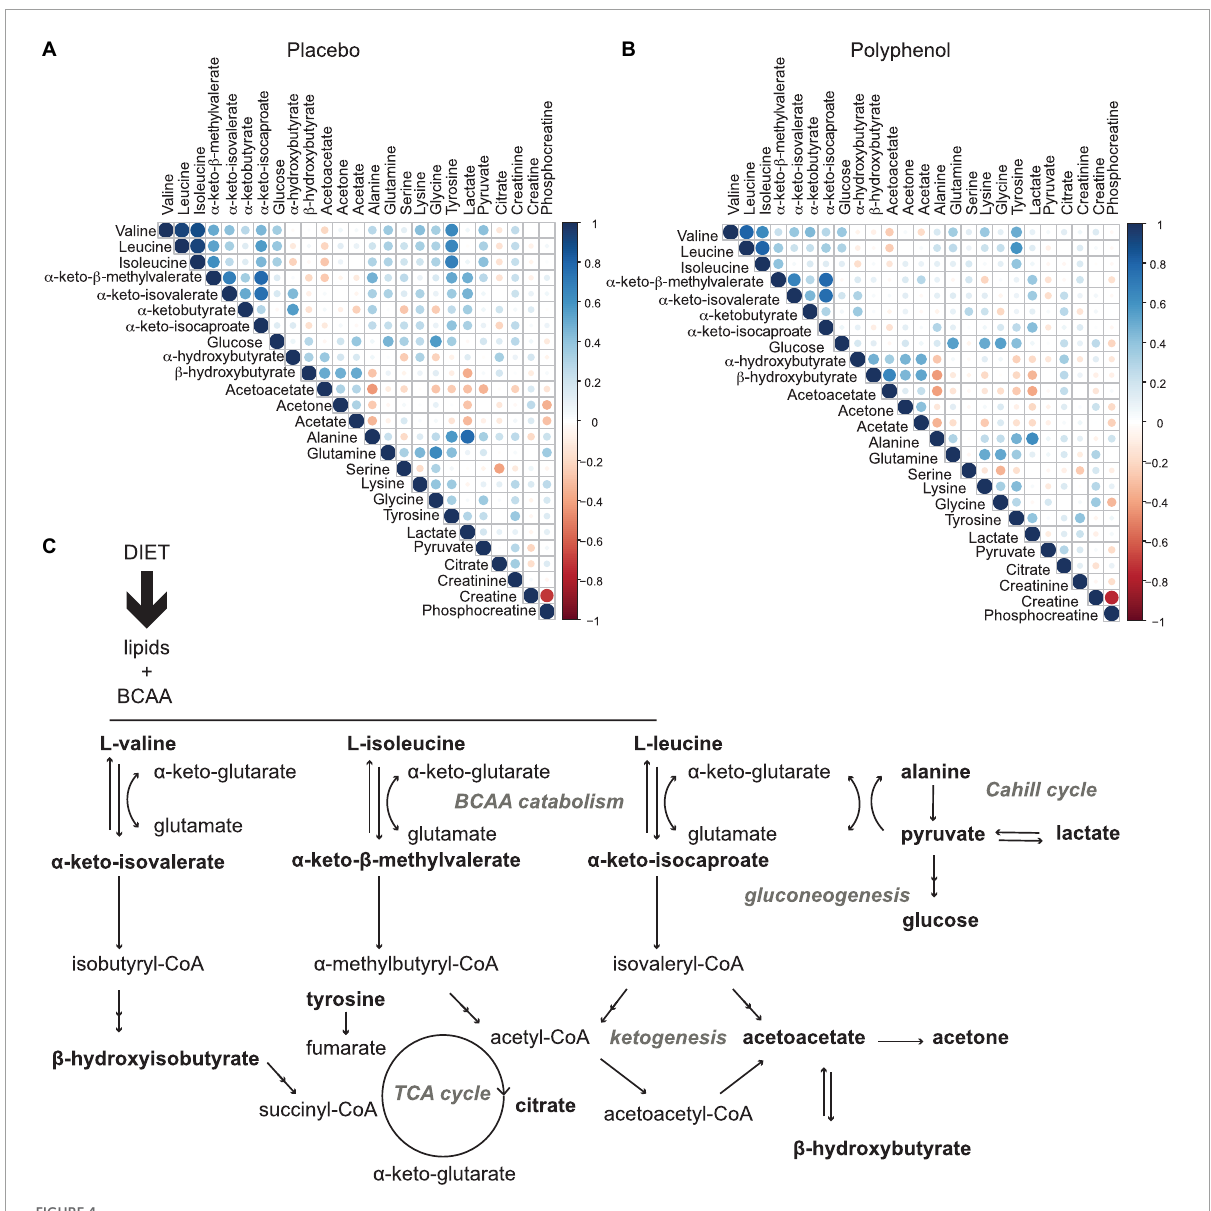
FIGURE4 Metabolic effects induced by overfeeding and polyphenol administration. (A) Metabolite correlation matrix obtained from the plasma metabolome analysis of the male “Lyon” study across all time points for all subjects for the placebo arm (overfeeding), and (B) , for the polyphenol arm (overfeeding and polyphenol administration). Non-significant correlations ( p -value > 0.05) were excluded. (C) metabolic pathways involved in diet-induced obesity, as observed in this study by plasma metabolomics: a profile with elevated circulating branched chain amino acids, BCAA (valine, isoleucine and leucine) and branched chain keto acids, BCKA ( α -keto-isovalerate, α -keto- β -methylvalerate, and α -keto-isocaproate) highlighting increased BCAA catabolism, leading to decreased TCA cycle activity (lower levels of citrate) and ketogenesis (lower levels of ketone bodies acetone, acetoacetate and β -hydroxybuturate), with an increased gluconeogenesis (higher levels of glucose) and lactate production through the Cahill cycle. Monitored metabolites are in bold. Pathway names are in